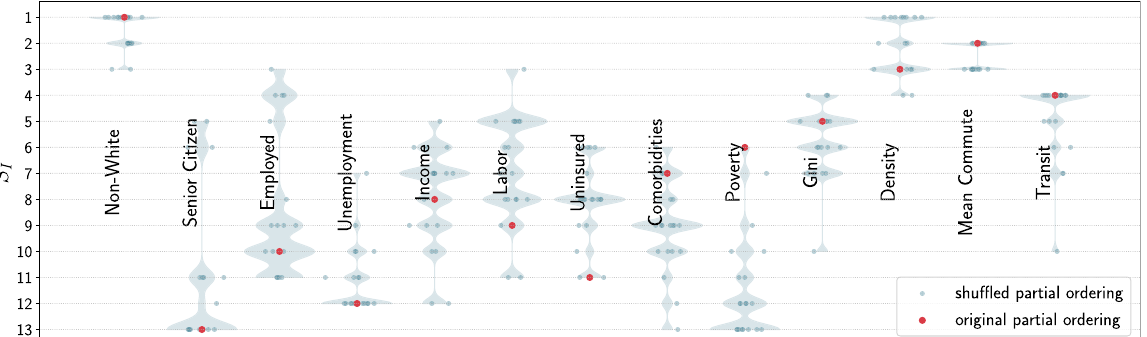
Figure 2. The Shapley Index, S I , of all the metrics from 20 different causal ordering where the ordering of the subgroups were randomized starting from the causal ordering used in the left panel. The plot shows that the variation in S I is small for the most important metrics with high | S v | while larger variations in S I can be seen in the less important metrics depending on the causal ordering. For more detail please see the